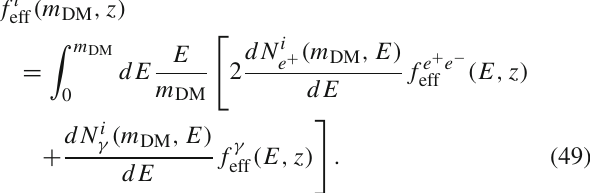
where α( E γ , z ) is the absorption coefficient and E (cid:3)(cid:3) γ = E (cid:3) γ ( 1 + z (cid:3)(cid:3) )/( 1 + z (cid:3) ) . For detailed description of